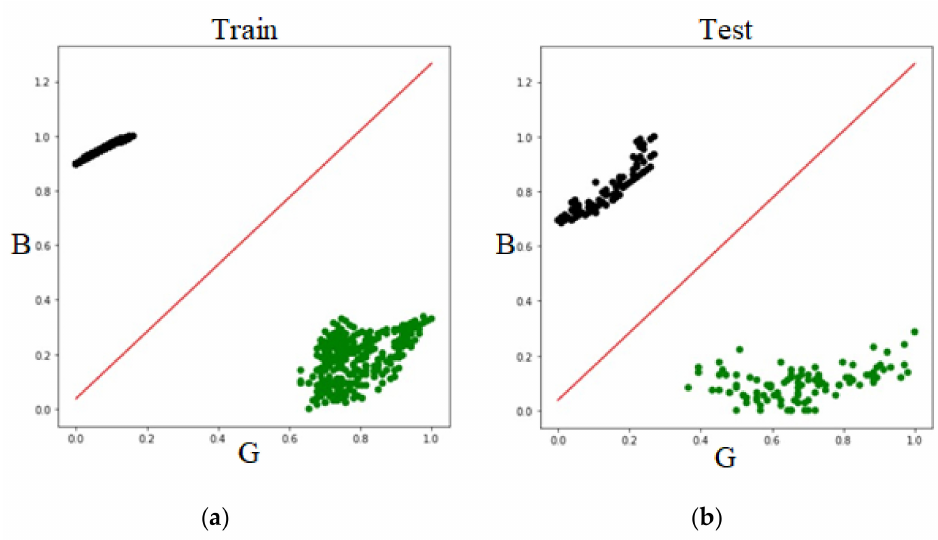
Figure 7. Schematic diagram of G-B in logistic regression. ( a ) Schematic diagram of training dataset. ( b ) Schematic diagram of testing dataset. Table 3. The accuracy and loss rate of training dataset and testing dataset in G-B logistic regression.